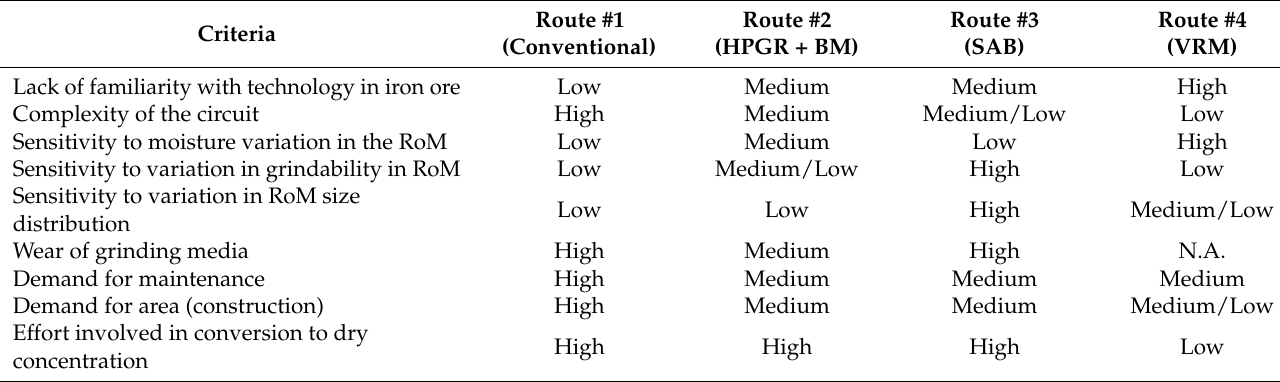
Table 4. Qualitative indices of technical and operational issues involved in each processing route analyzed.